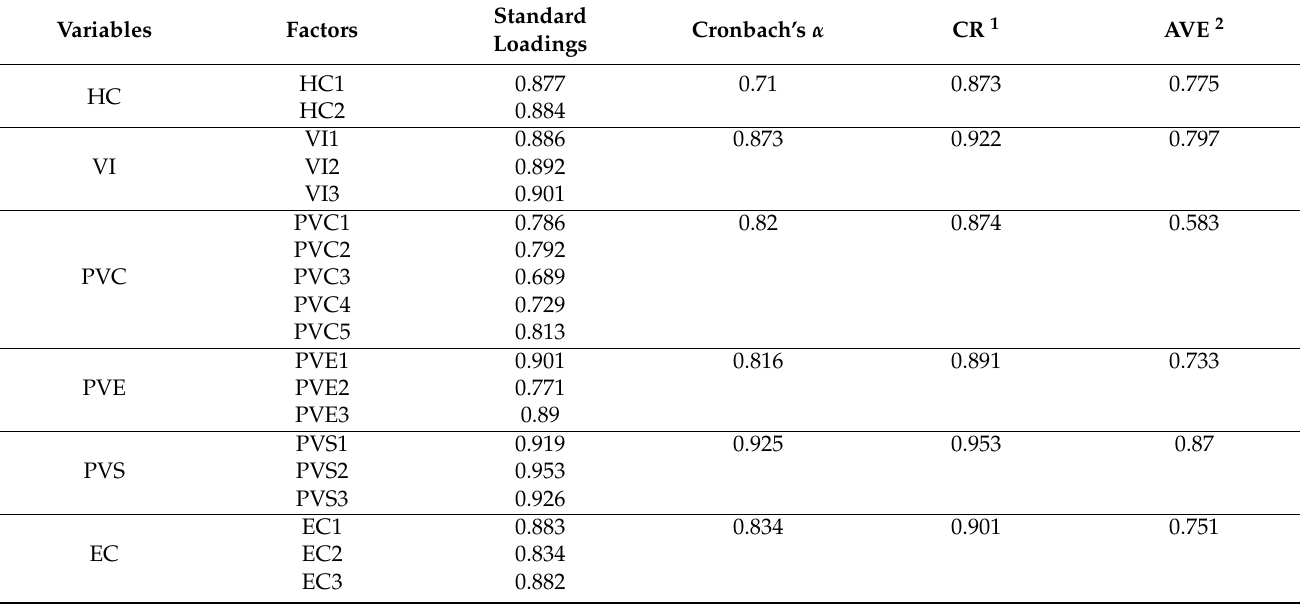
Table 3. Results of the reliability and convergent